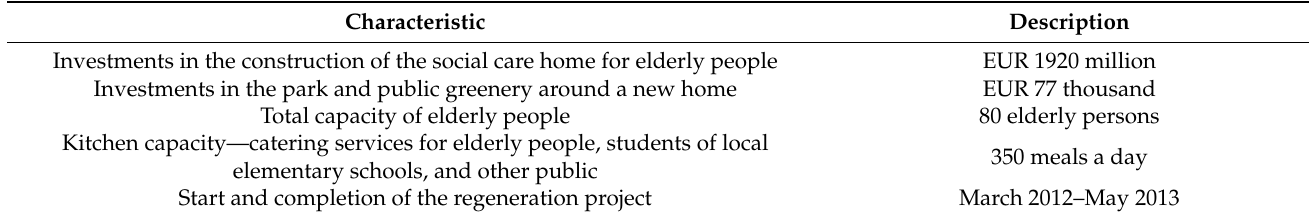
Table 1. The selected basic characteristics of the regeneration project in Vranovice.